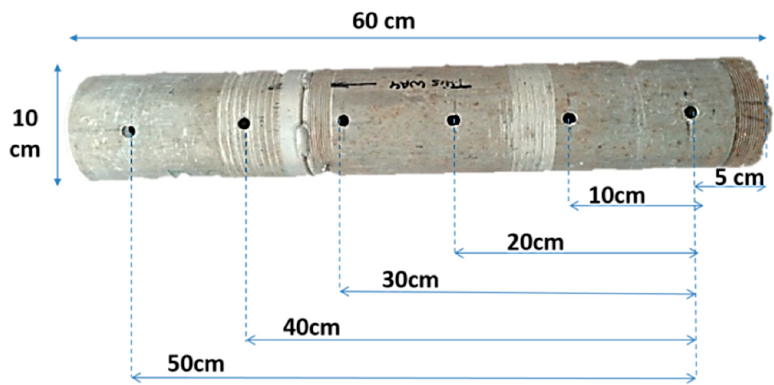
Figure 2. Aluminium container with the six holes with 10cm apart from each other. The holes are paced in order to measure signal intensity in different distances from the signal transmitter.